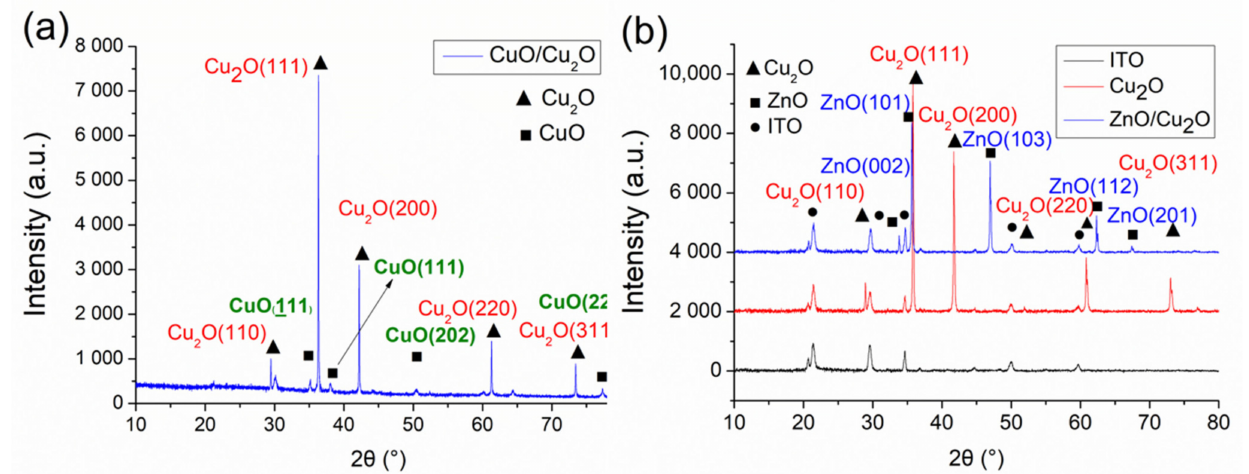
Figure 3. XRD patterns of ( a ) CuO/Cu 2 O and ( b ) fabricated ZnO/Cu 2 O